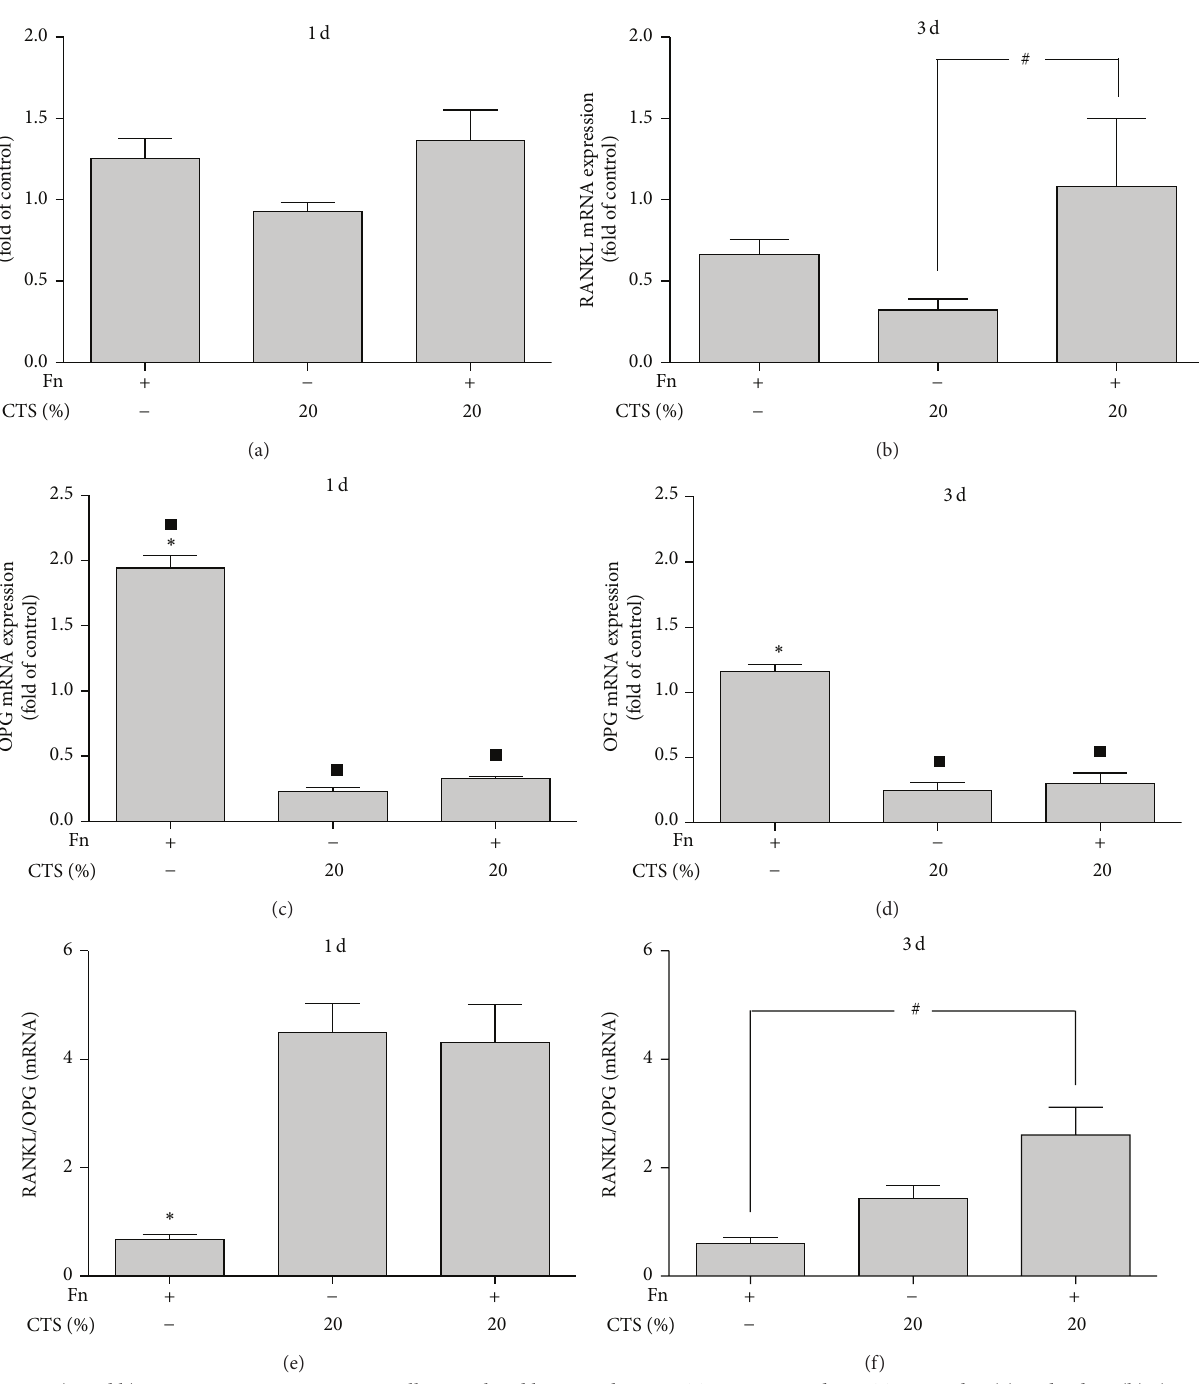
Figure 3: (a and b) RANKL expression in PDL cells stimulated by F. nucleatum ATCC 25586 and/or CTSH at 1 day (a) and 3 days (b). (c and d) OPG expression in PDL cells stimulated by F. nucleatum ATCC 25586 and/or CTSH at 1 day (c) and 3 days (d). (e and f) RANKL/OPG mRNA ratio in PDL cells stimulated by F. nucleatum ATCC 25586 and/or CTSH at 1 day (e) and 3 days (f). ∗ Significant difference compared to other groups ( 𝑃 < 0.05 ), ◼ significant difference compared to control ( 𝑃 < 0.05 ), and # significant difference ( 𝑃 < 0.05